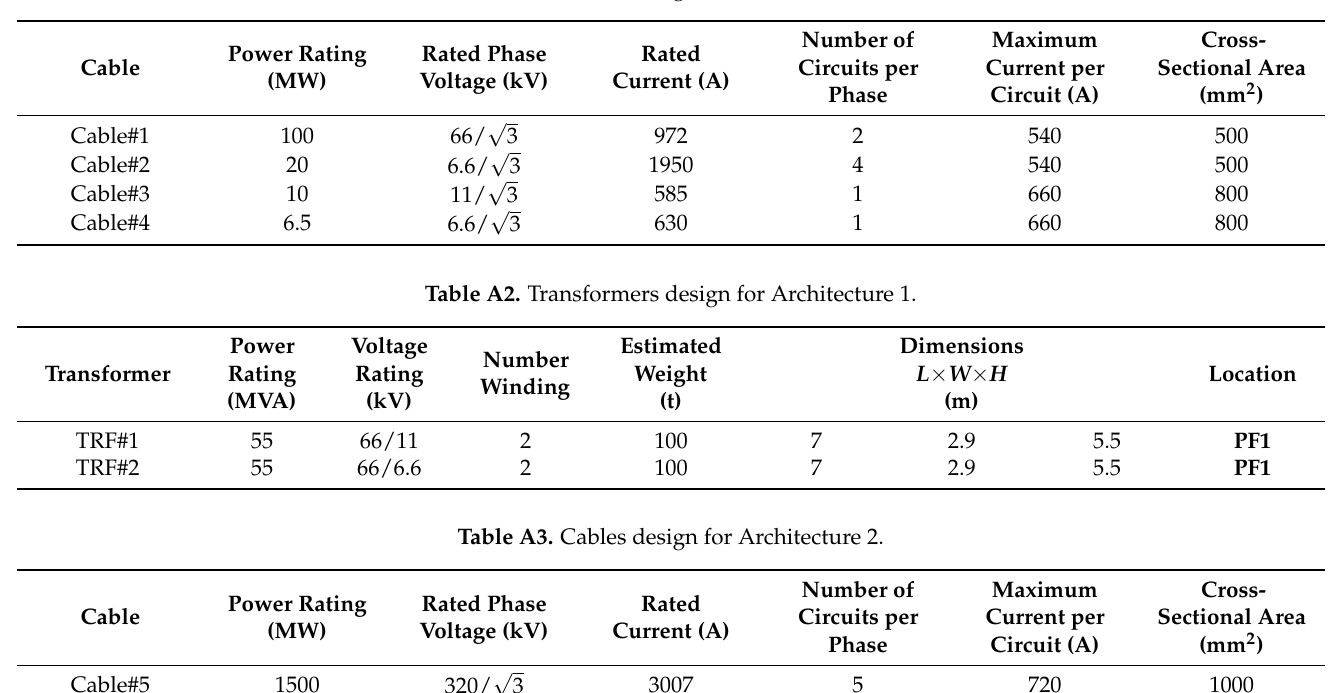
Table A1. Cables design for Architecture 1.